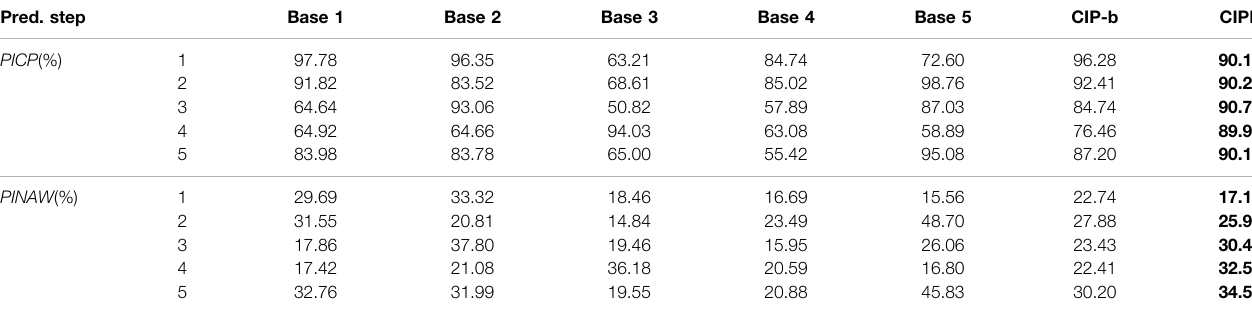
TABLE 3 | Multi-step ahead prediction results of different base models, CIP-b, and CIPE under PINC = 90%. Pred. step